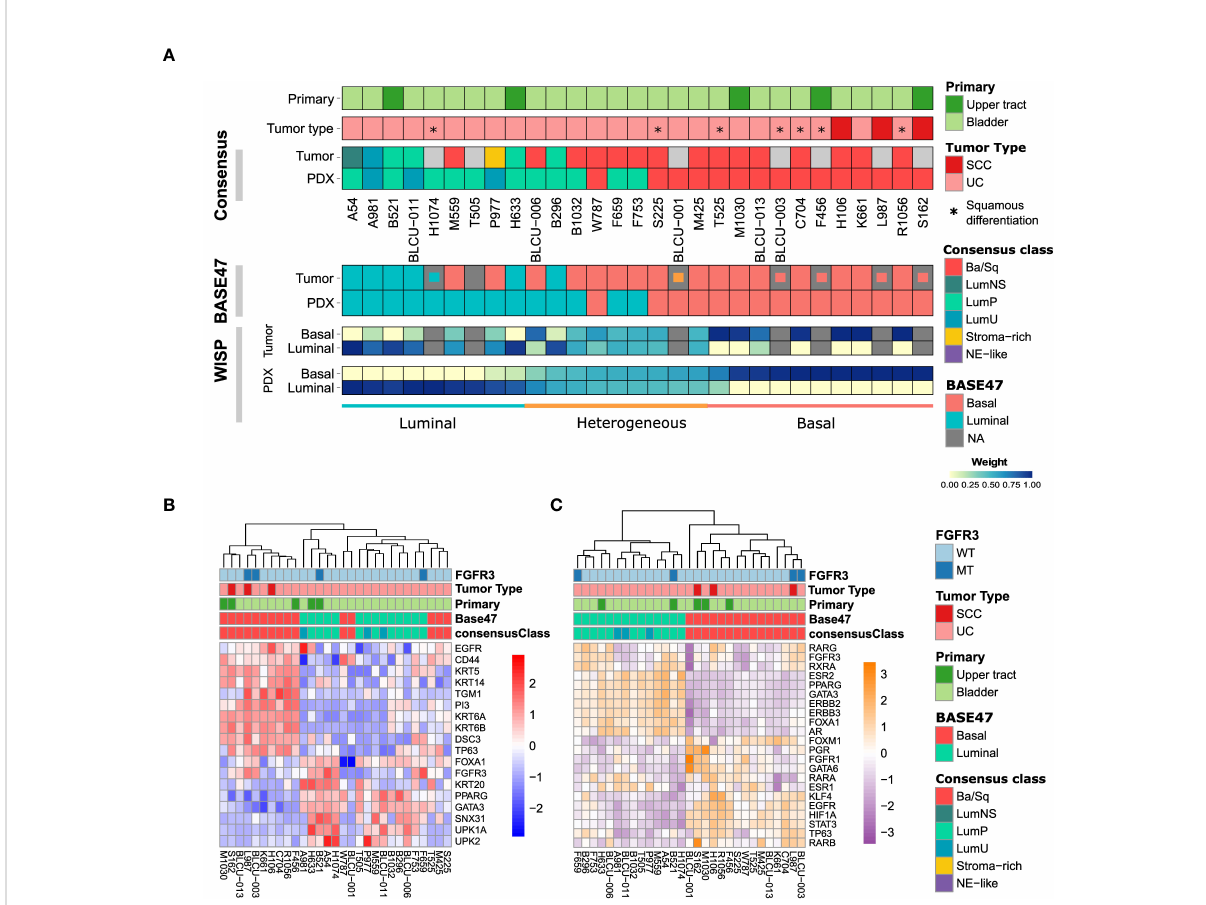
FIGURE 2 Transcriptomic analysis of patient tumors and paired PDXs. (A) Tumors and PDXs were classi fi ed into six subtypes using transcriptomic Affymetrix U133plus2 array data according to the molecular consensus classi fi er developed for MIBC, the corresponding box colors indicated in the legend on the right. A total of 22 patient tumor – PDX pairs and 7 individual PDXs were analyzed, where tumors without transcriptomic data are indicated in gray. Urothelial carcinomas with divergent squamous differentiation are highlighted with *. (B) Upper panels: tumors and PDXs were classi fi ed using transcriptomic data as luminal and basal subtypes according to the BASE47 classi fi er (27). In patient tumors with missing transcriptomic data, we assessed the luminal (blue), basal (red), or heterogeneous (orange) subtype by immunohistochemistry (IHC; inset small boxes), as de fi ned in methods. Lower panels: the intra-tumoral heterogeneity and proportion of luminal and basal subtype admixture as evaluated from transcriptomic pro fi les using the WISP (Weighted In Silico Pathology) algorithm. Based on the PDX WISP results, samples were molecularly classi fi ed as luminal, basal, or heterogeneous. (B) Heatmap of PDX samples based on the gene expression of selected luminal or basal markers. (C) Heatmap of PDX samples based on the regulon activity of the main regulators previously identi fi ed within the different molecular subtypes of MIBC (9,